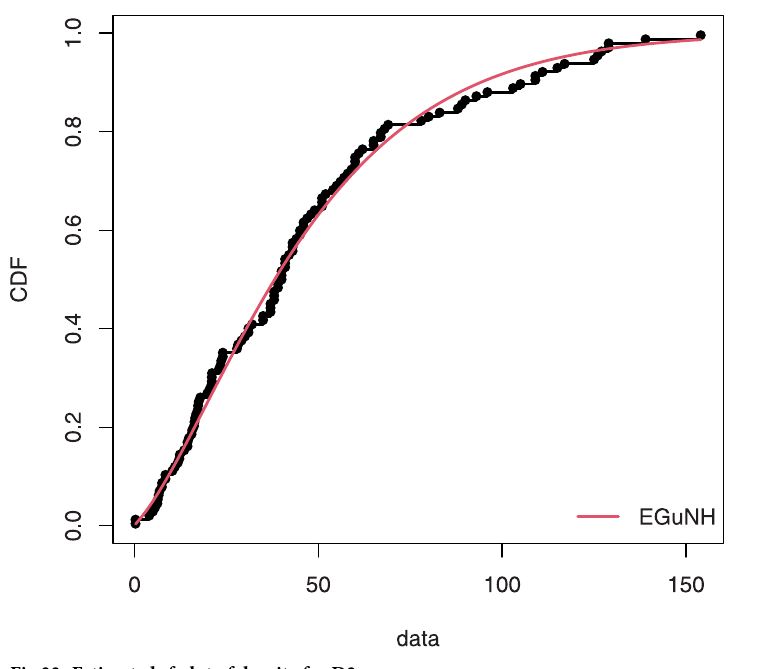
Fig 33. Estimated sf plot of density for D2.